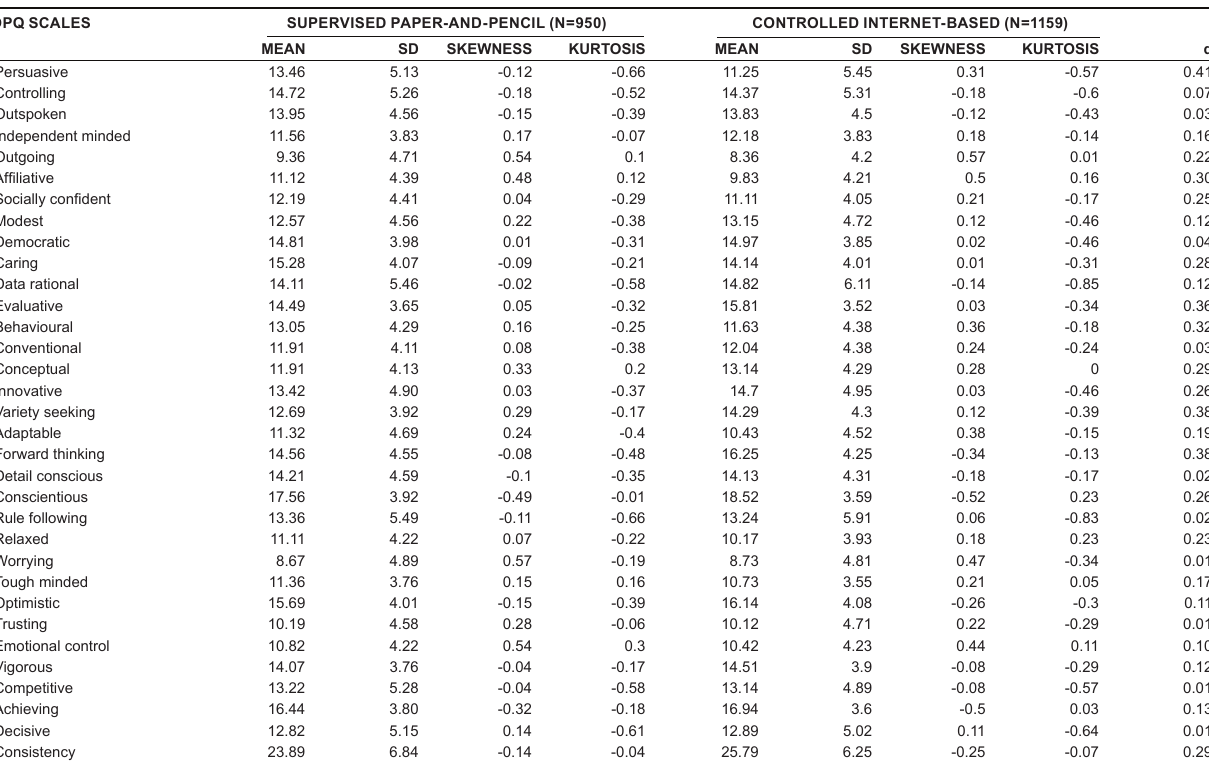
Table 2 Descriptive statistics and estimated effect sizes of differences between means of managerial supervised paper-and-pencil and controlled Internet-based OPq32i results (study 2) OPQ ScaleS SuPerviSed PaPer-and-Pencil